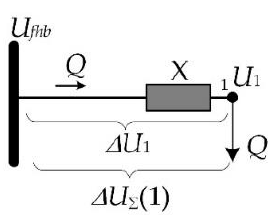
Figure A1. Equivalent circuit of the first term of (10).